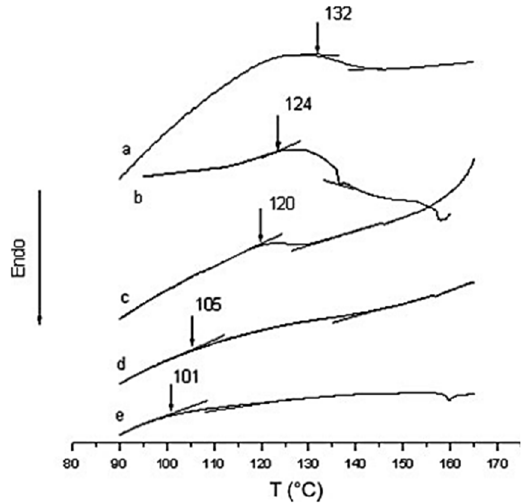
Figure 13. DSC curves of the polyurea samples (( a ) aromatic polyurea; ( b – d ) co-polyureas; ( e ) ali-phatic polyurea). From reference [42].